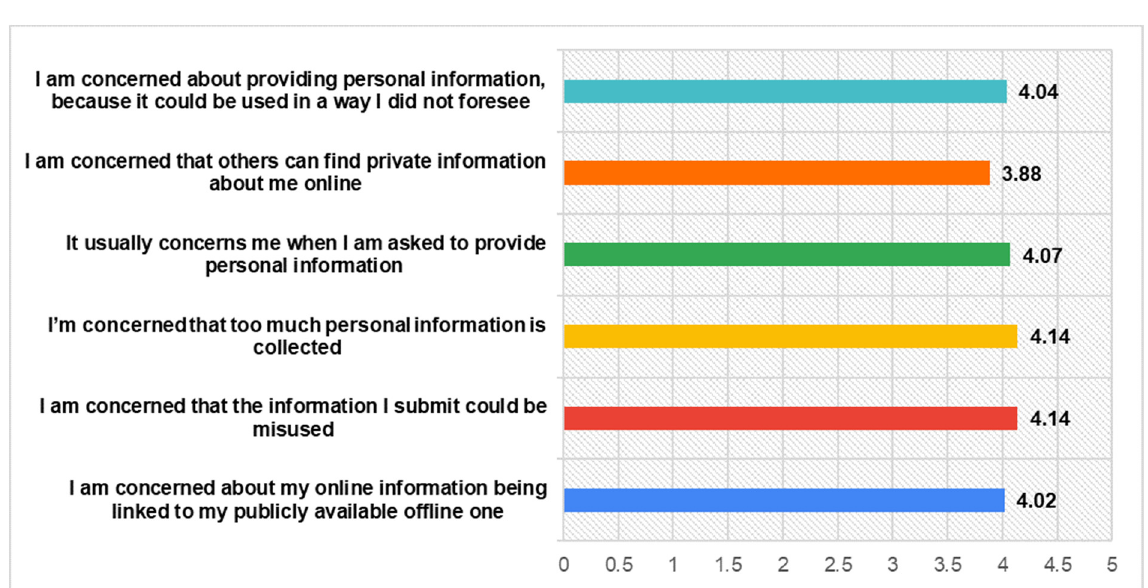
Figure 2. Privacy Concerns.